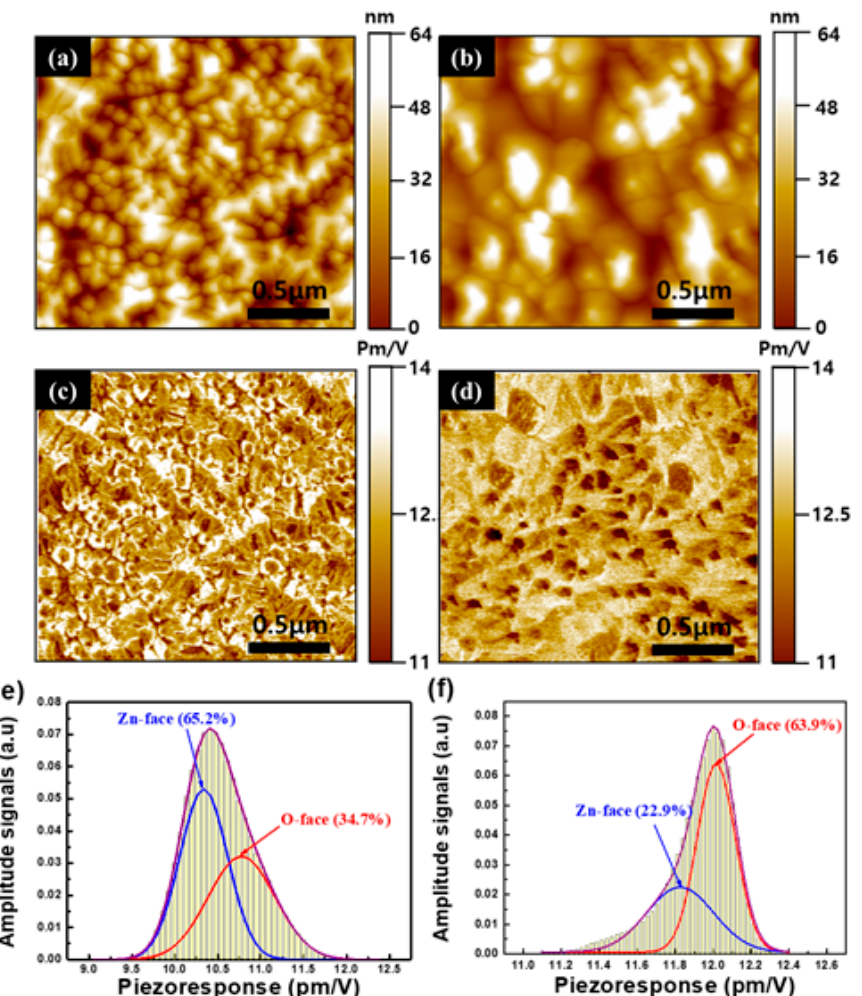
Figure 3. The topography, piezoresponse force microscopy (PFM)-phase images, and histograms of the ZnO films grown on ( + z) LiNbO 3 and (-z) LiNbO 3 . The topography images of the ZnO films grown on ( + z) LiNbO 3 ( a ) and (-z) LiNbO 3 ( b ), respectively. The corresponding PFM-phase image of the ZnO films grown on ( + z) LiNbO 3 ( c ) and (-z) LiNbO 3 ( d ), respectively. The piezoresponse histogram taken from the PFM images of the ZnO films grown on ( + z) LiNbO 3 ( e ) and (-z) LiNbO 3 ( f ),